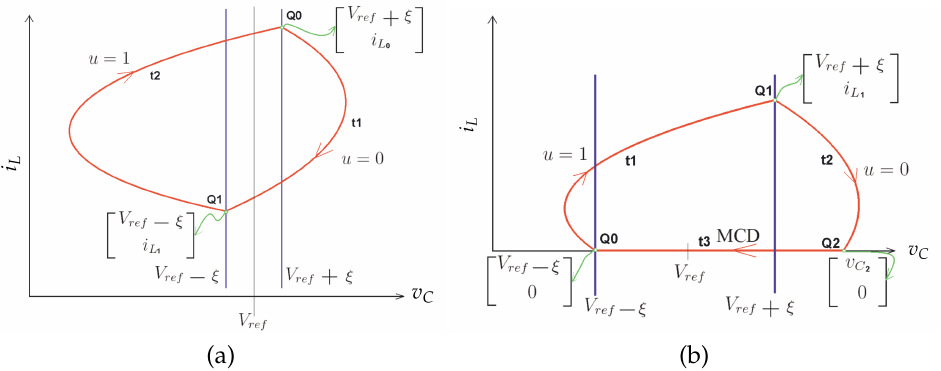
Figure 13. 1 T -periodic orbits with the constant hysteresis control: ( a ) 1 T -periodic orbit in CCM mode ( i L > 0), combining two solution pieces for S = 1 and S = 0; and ( b ) 1 T -periodic orbit in DCM ( i L ≥ 0), combining three solution pieces for S = 1, S = 0 in CCM and for i L =